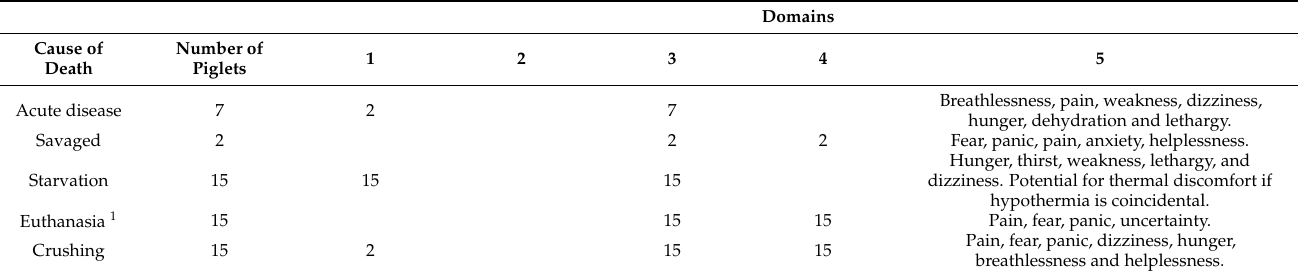
Table 4. Summary of causes of death and the number of piglets experiencing Domain compromises. The likely affective states are described for each cause in Domain